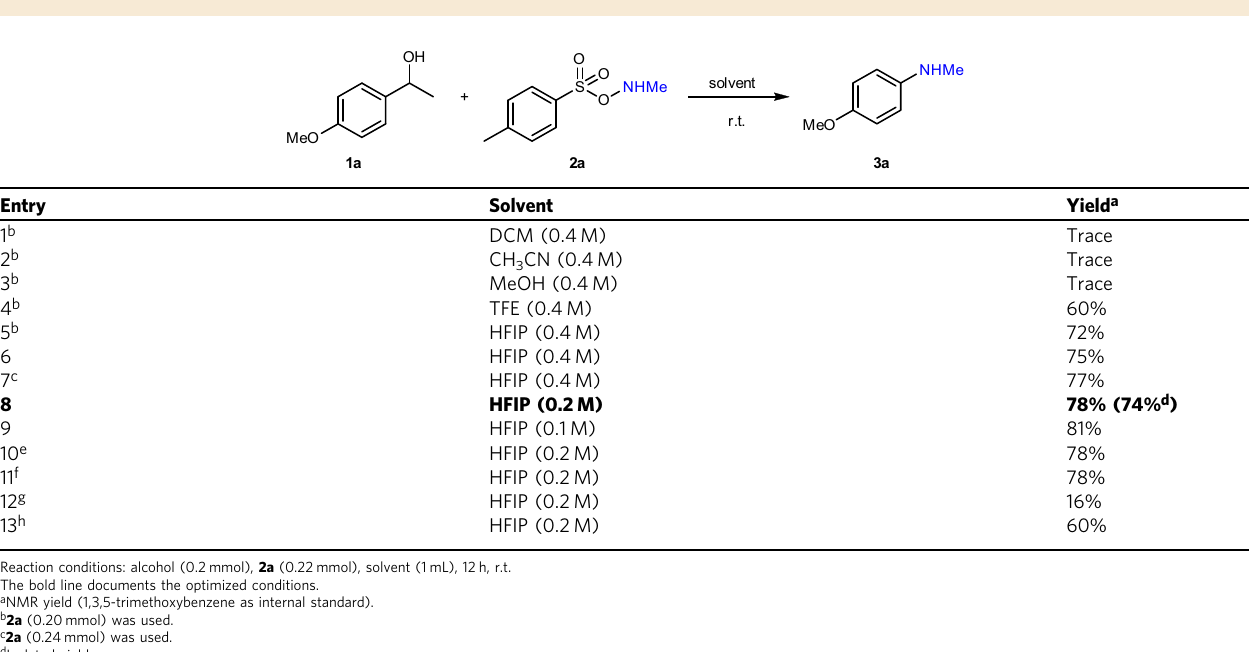
Table 1 Optimization of the C – C amination towards secondary